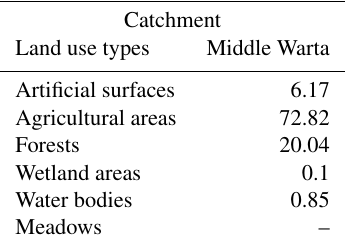
Table 2. Land use types with the percentage of participation in the catchment area (source: CORINE,